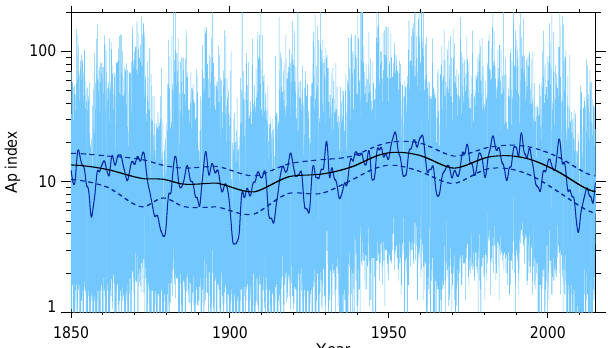
Figure I1. Decomposition of the reconstructed Ap index in the scaling procedure. Light blue: daily resolved Ap; black: background compo- nent Ap bg ; solid dark blue: annual component Ap a ; dashed dark blue: scaling function SD(Ap a ), multiplied by 1 and − 1, used to scale the annual